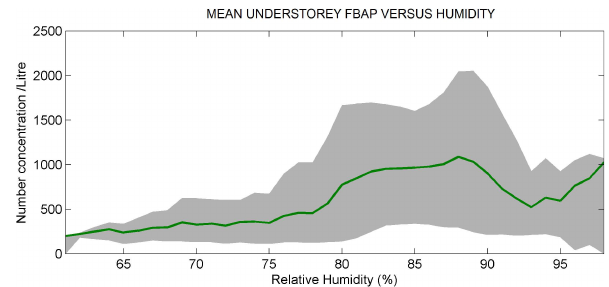
Fig. 7. Understorey N FBAP as a function of ambient RH. Line de- picts the mean N FBAP and the shaded region the interval between the 10th and 90th